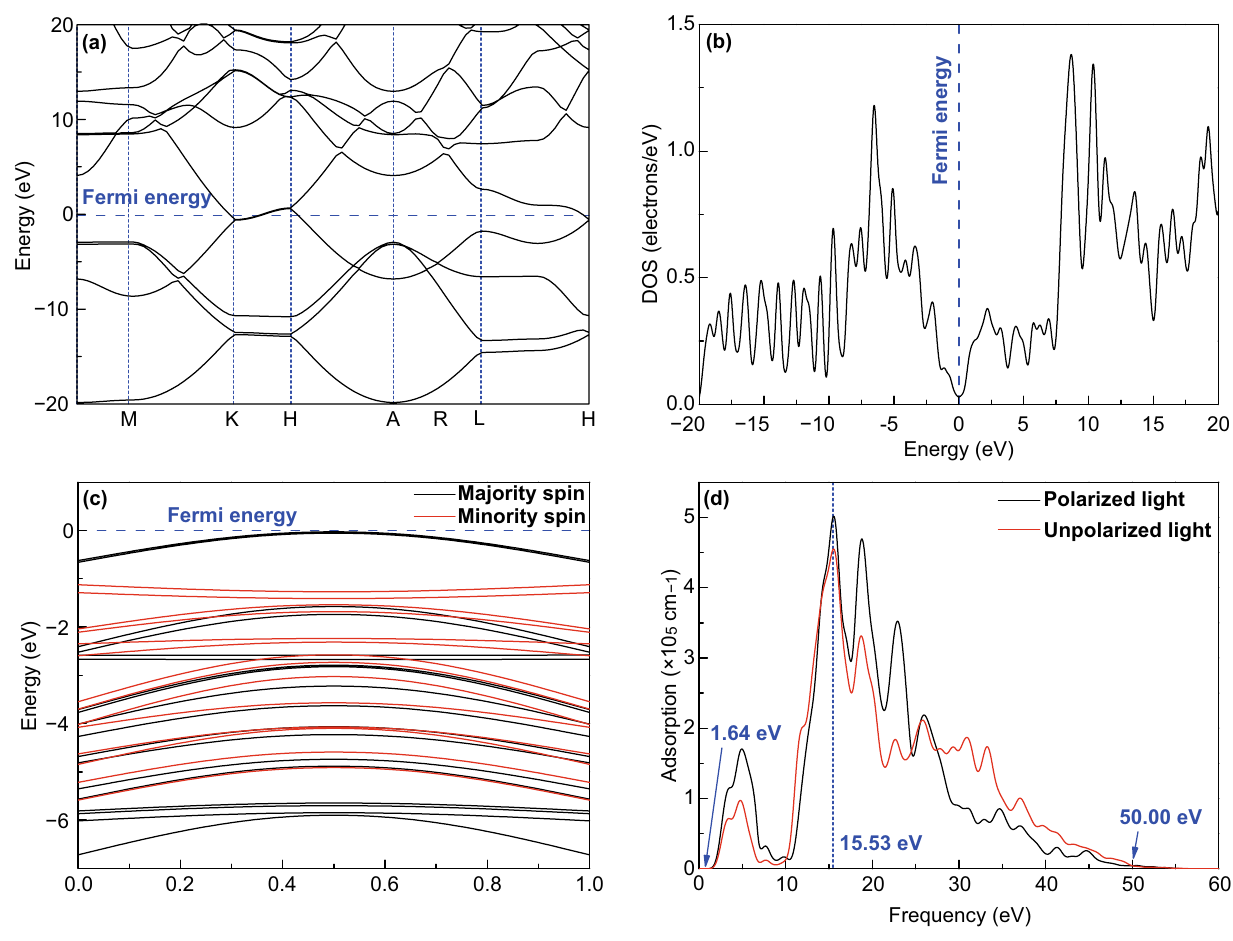
Fig. 7 a Kohn–Sham band structure, b density of states, and c band structure of the majority/minority spin of graphene. The Fermi energy is set as zero and indicated by blue dashed line. d The absorption spectra under polarized light in the direction of (1, 0, 0) and unpolarized